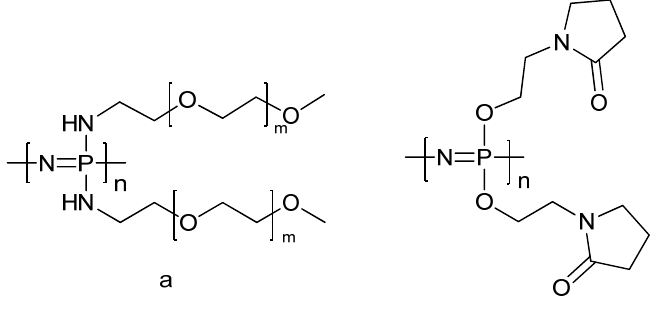
Figure 8. Polyphosphazenes substituted with ( a ) monomethoxy amino PEG and ( b ) N-ethylpyrrolidone